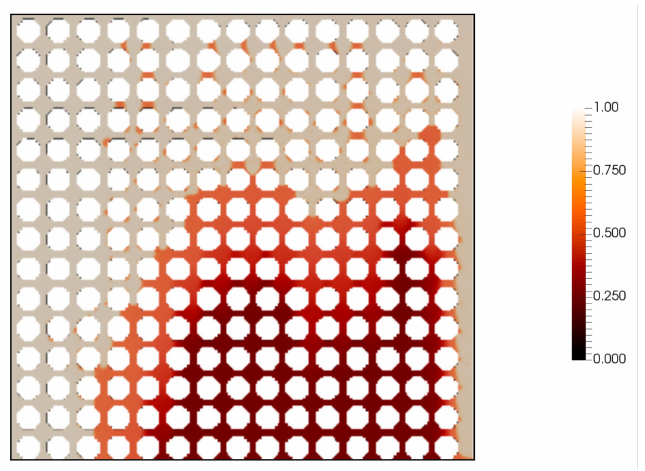
Figure 12. Butane mole fraction distribution in the porous media after 4.2 h. Butane mole fraction differs in the range of 1.0 (grey)—meaning pure solvent phase—to 0.0 (maroon)—meaning no solvent present in the phase.